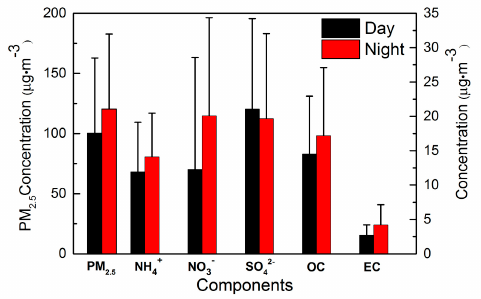
Figure 3. Day–night variations of PM 2.5 and main chemical components.